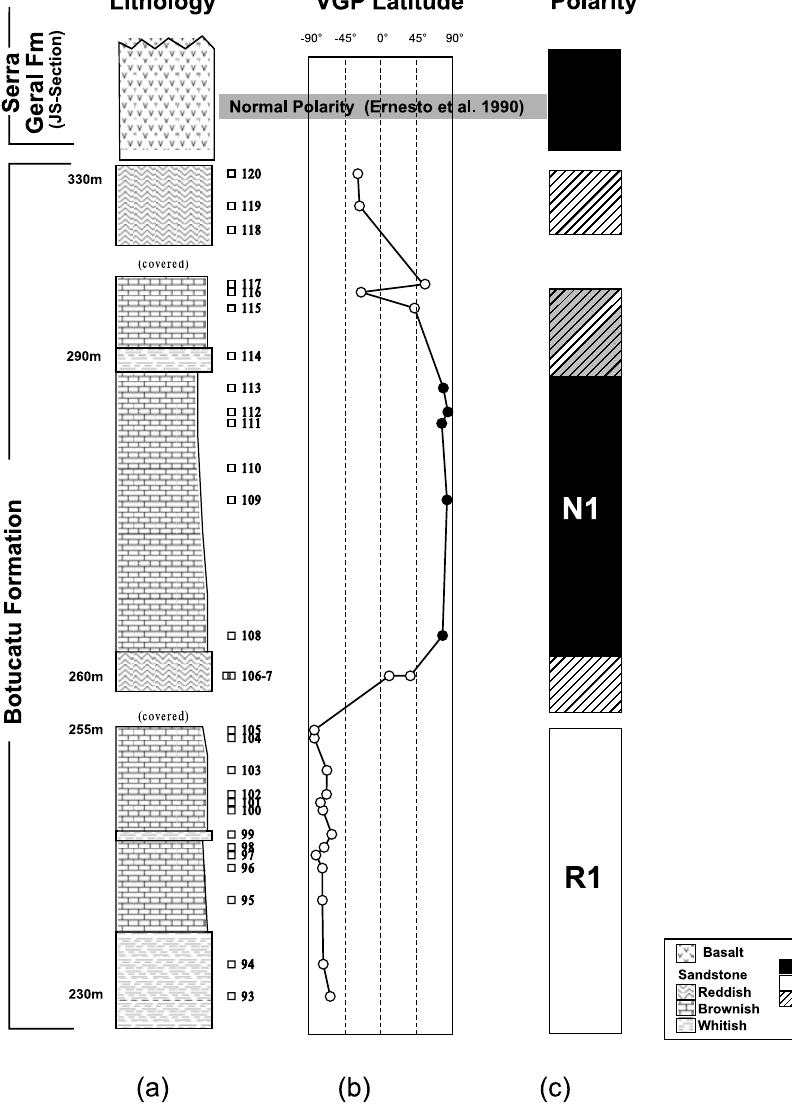
Fig. 9 – (a) Lithological column indicating the sample positions; (b) variation of the virtual geomagnetic pole (VGP) latitudes; (c) corresponding magnetic polarity stratigraphy showing normal (black) and reversed (white) polarities. Transitional or anomalous VGPs are indicated by hatched